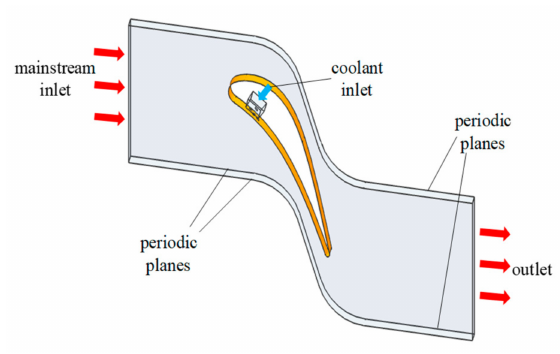
Figure 3. Schematic diagram of the computational